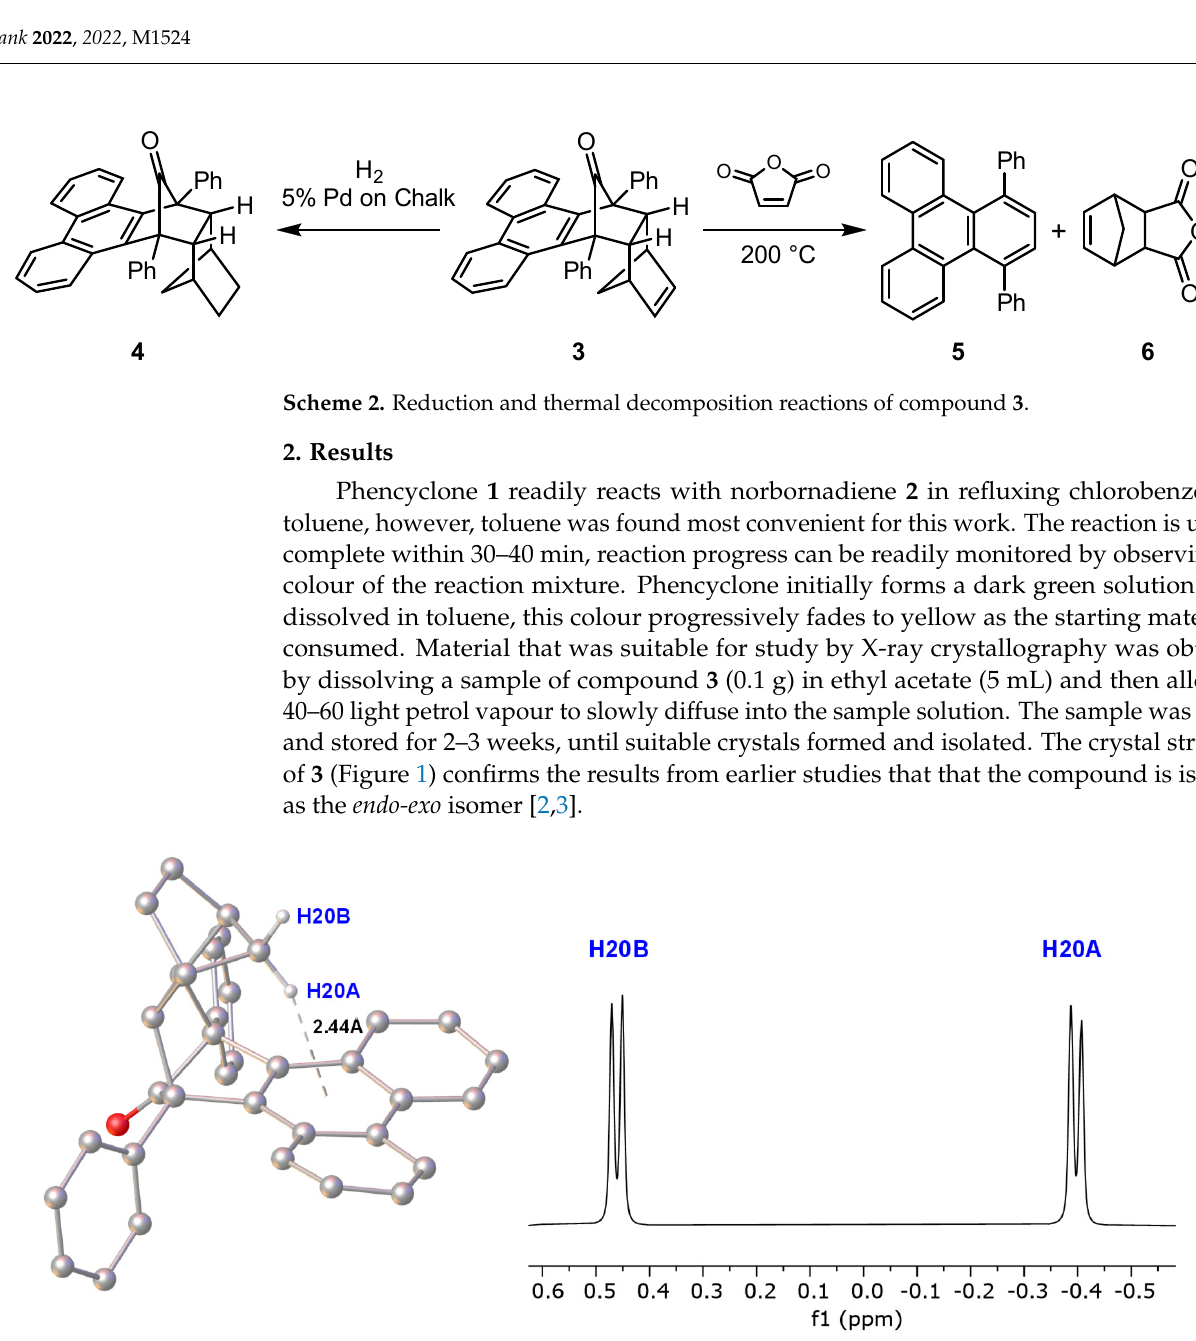
Figure 1. 1 H NMR spectrum expansion showing the norbornyl bridgehead CH 2 signals of bicy- clo[2.2.1]heptene 3 . The X-ray crystal structure has been superimposed and the distance between H20A and the phenanthrene ring system (2.44 Å) is highlighted.